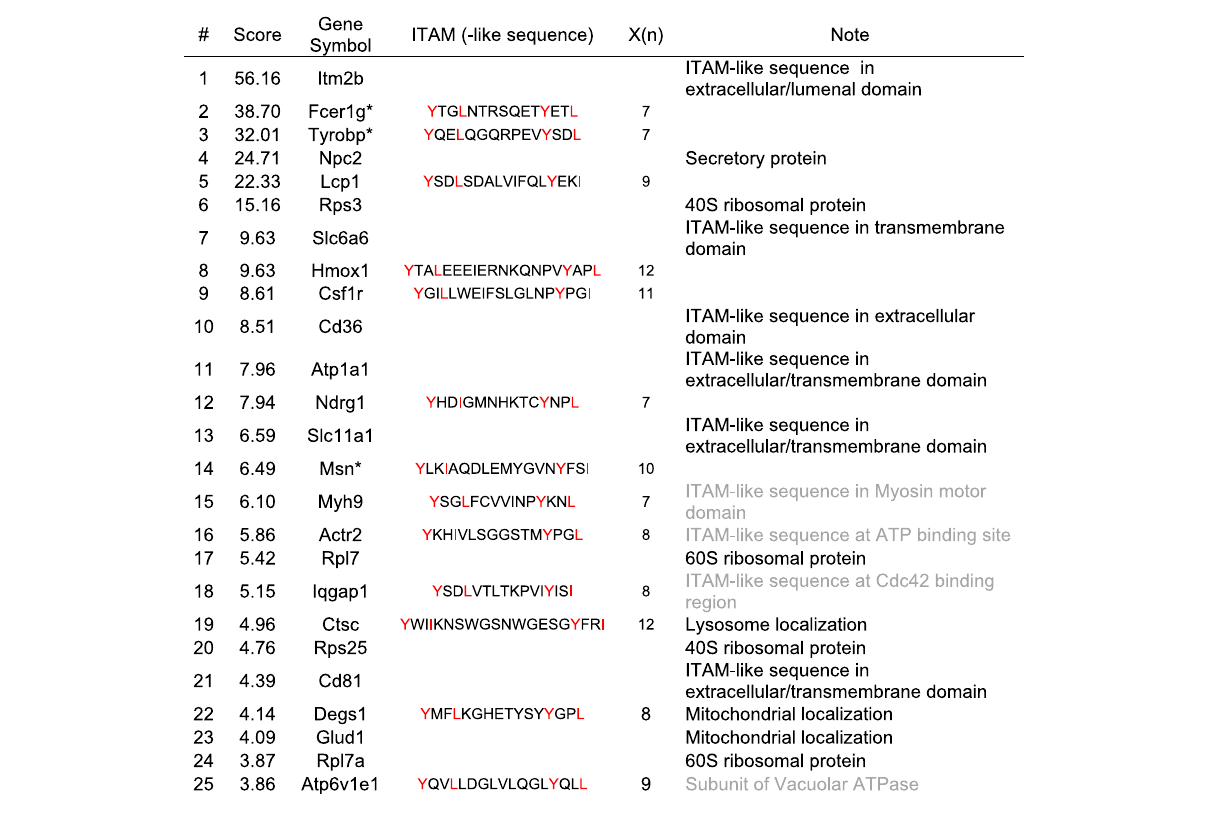
residues for ITAM